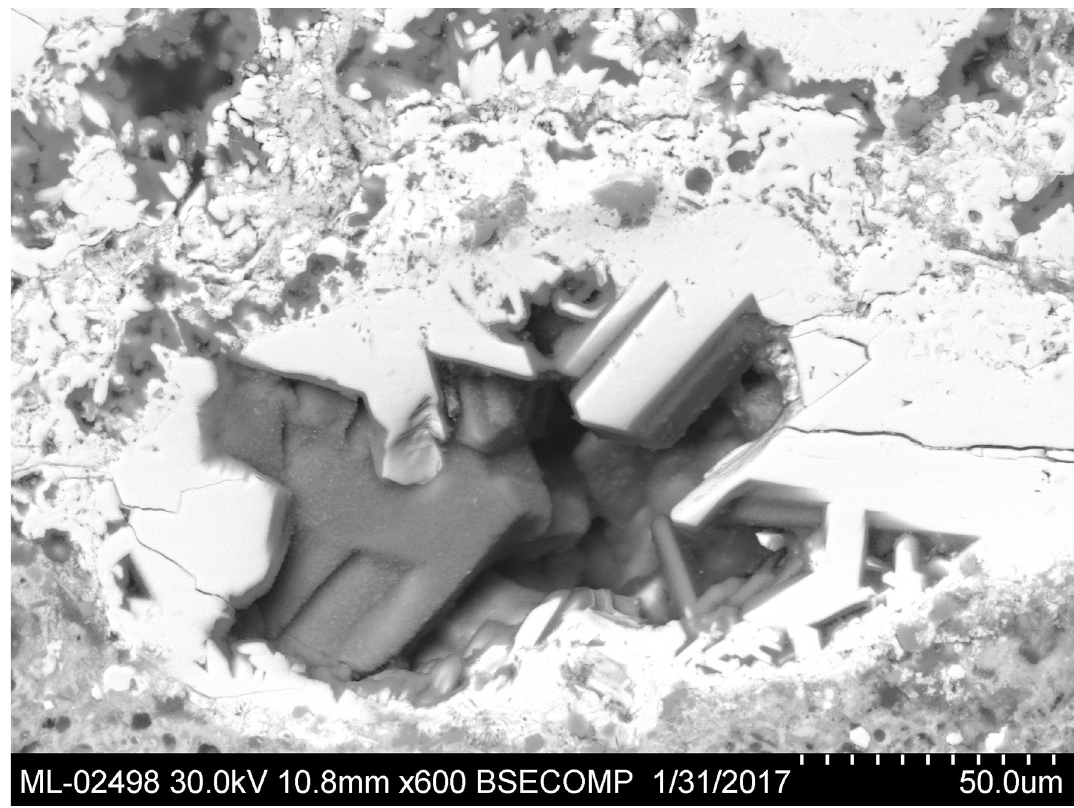
Fig 22. Secondary crystalline lead oxide within a microscopic cavity in the Bleje ş ti 1–1 sample. SEM image, backscattered electrons (S. Rovira).